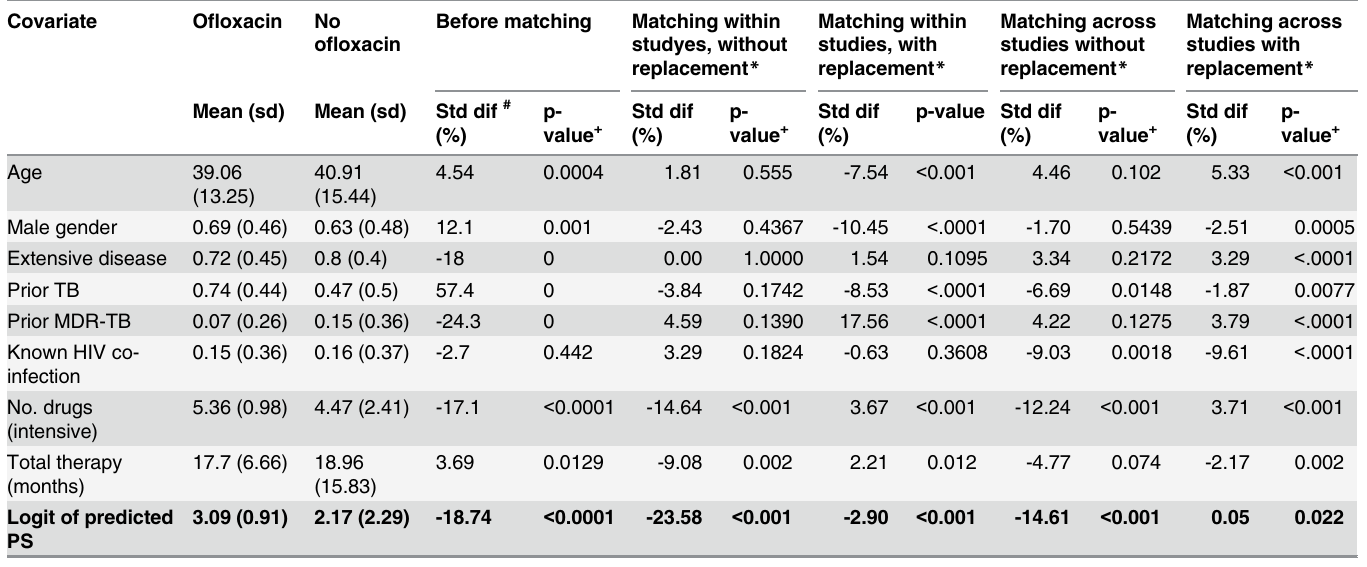
Table 4. Balancing achieved by different propensity score-based matching strategies for earlier generation fluoroquinolone use. Covariate O fl oxacin No Before matching Matching within Matching within Matching across Matching across o fl oxacin studyes, without studies, with studies without studies with replacement * replacement * replacement * replacement * Mean (sd)